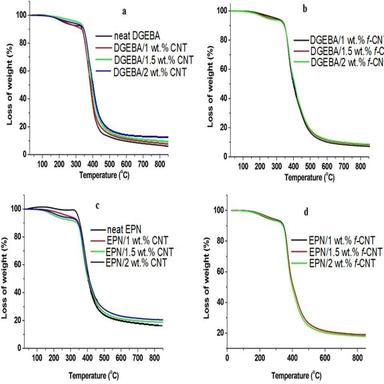
TGA curves of: a) DGEBA/CNT composites; b) DGEBA/f-CNT composites; c) EPN/CNT composites; d) EPN/f-CNT composites at 1.0, 1.5 and 2.0 wt% filler.